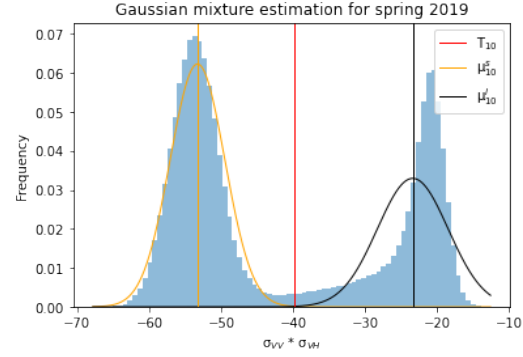
Figure 6. Gaussian mixture estimation for the parameters involved in the NLWI metric for the Spring 2019